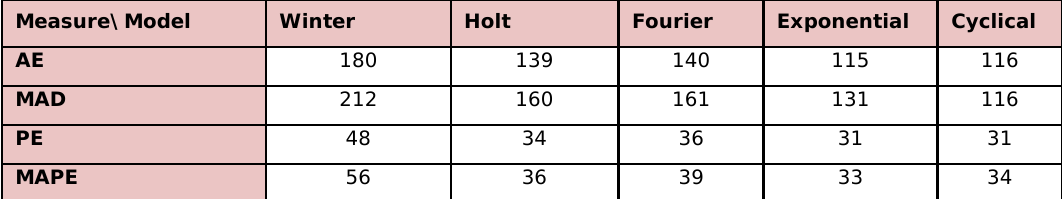
Table 6. “Comparative statistics of forecasting accuracy”